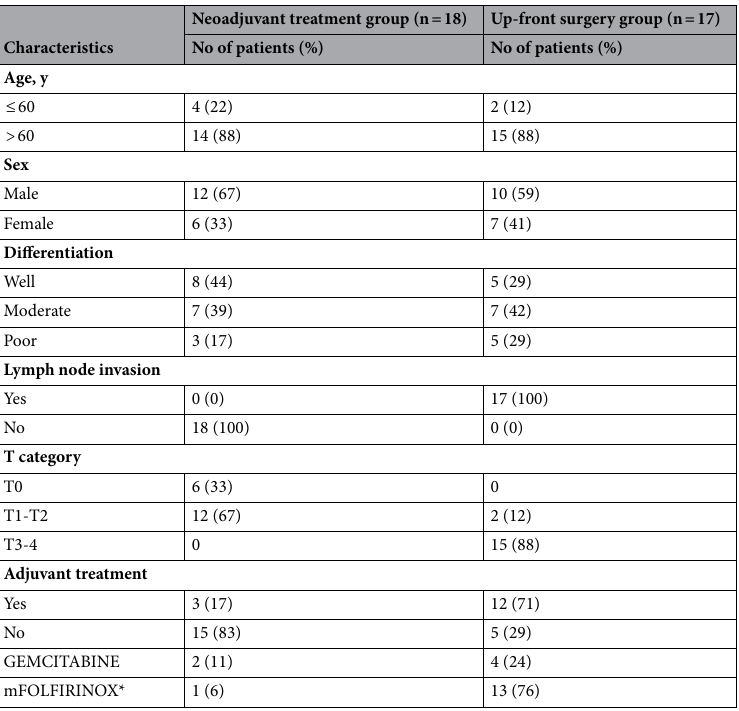
Table 1. Clinicopathologic characteristics of the study patients. *Modified